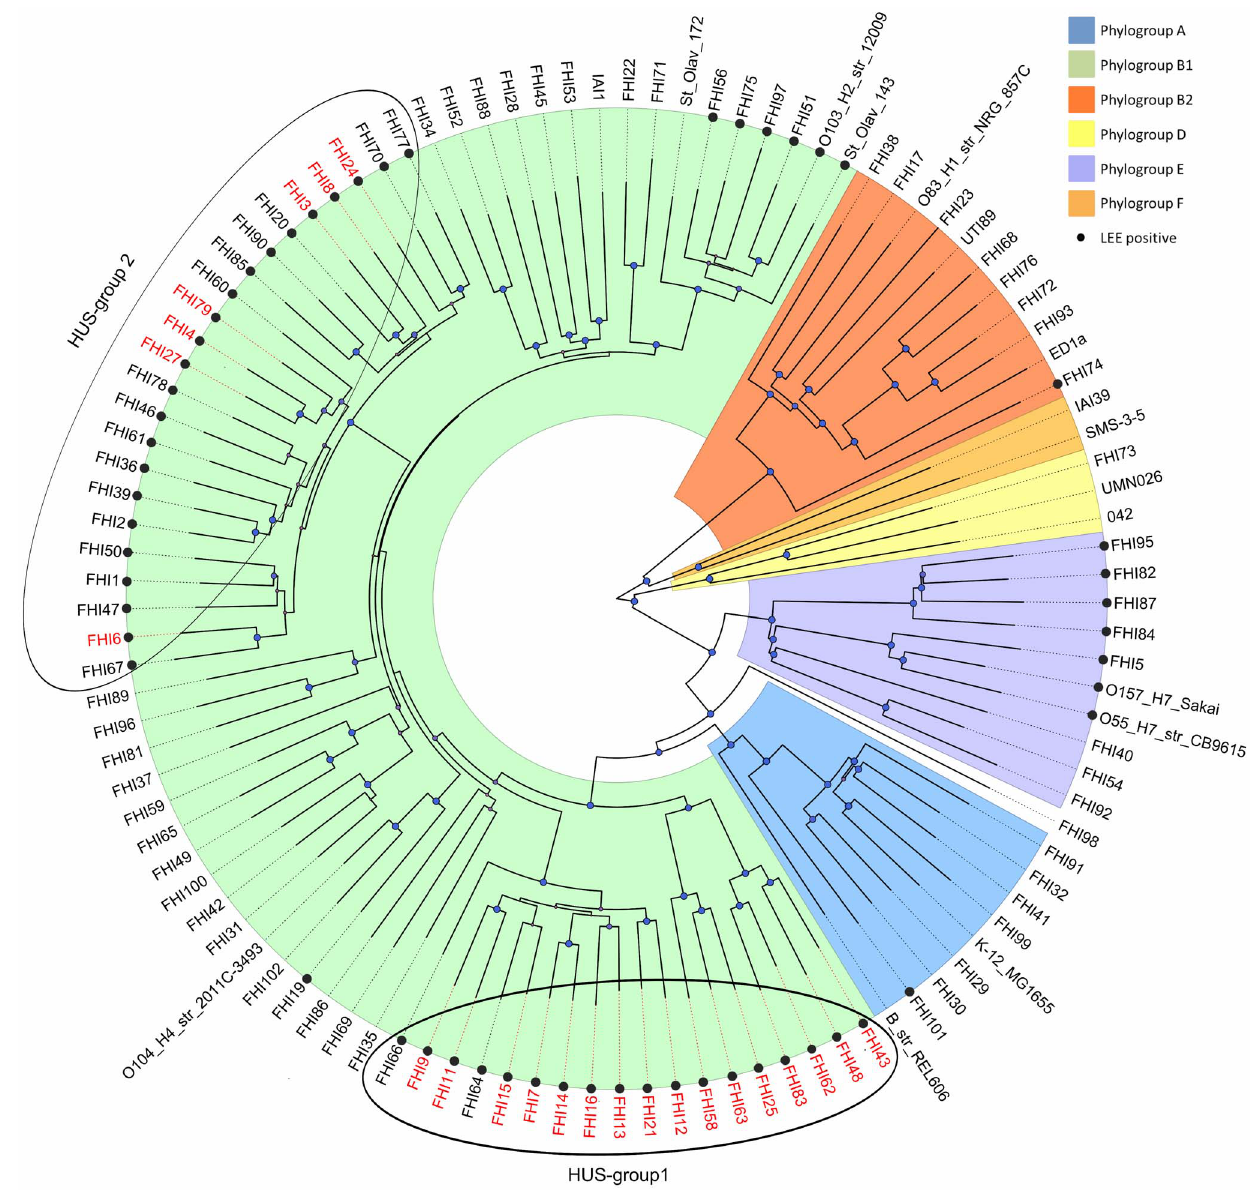
Figure 1. Core gene phylogeny of the 95 sequenced non-O157 STEC and 14 E.coli reference genomes. The tree was rooted in Figtree (http://tree.bio.ed.ac.uk/software/figtree/) by midpoint rooting. For an unrooted version of the phylogenetic tree, see Figure S1. The E. coli phylogroups are marked with the colours blue (A), green (B1), orange (B2), yellow (D), ochre (F) and indigo (E). Bootstrap values were scaled from 0–1, and blue circles indicate a bootstrap value of $ 0.8. LEE positive STEC were marked with study were indicated with red letters.